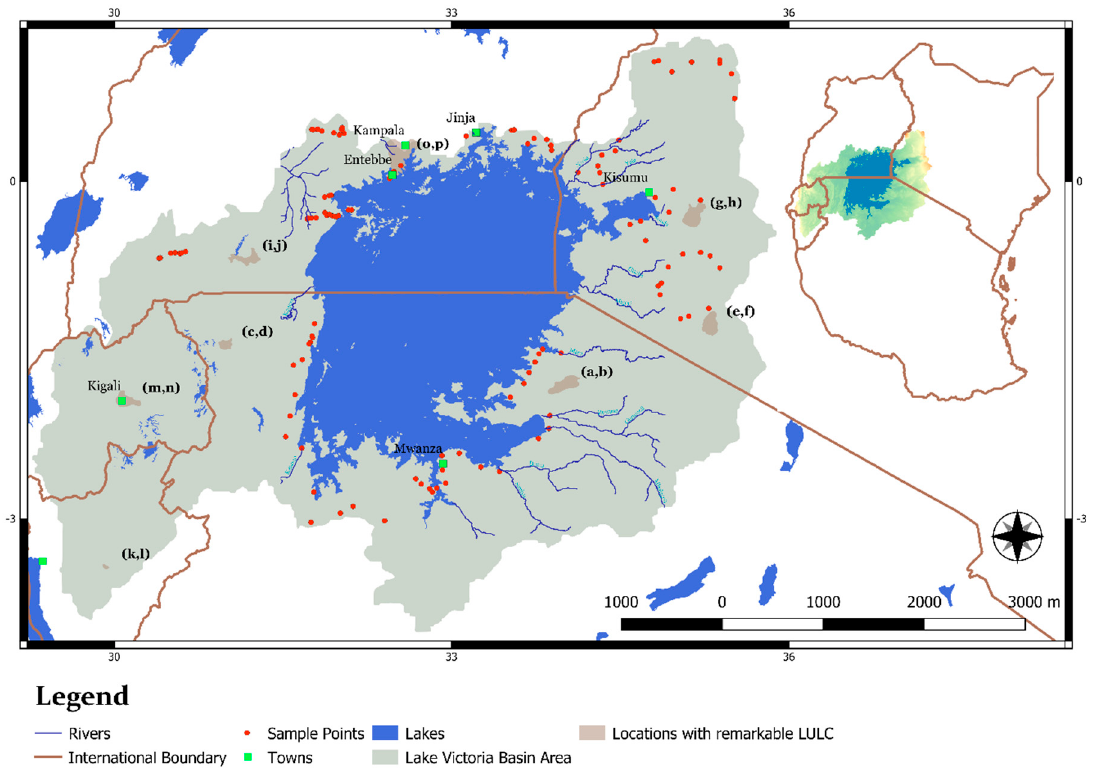
Figure 1. A map of the Lake Victoria Basin, showing locations where reference data were collected (red dots) in parts of the basin in Uganda, Kenya, and Tanzania. The brown polygons marked with letters show selected locations where change in land cover is remarkable.